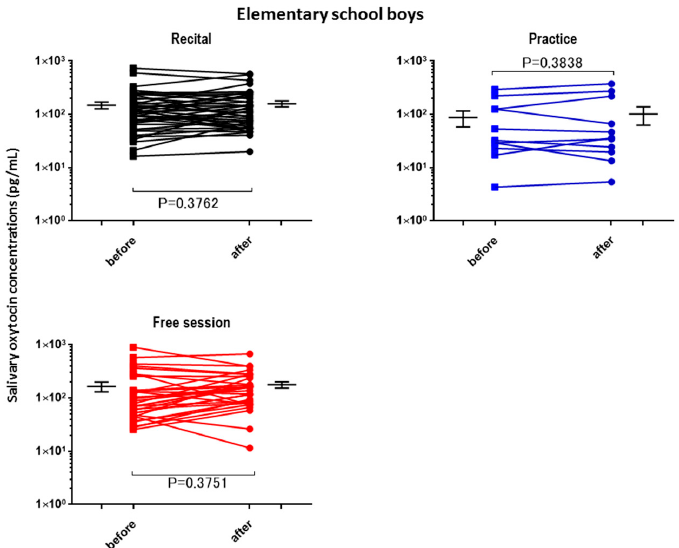
Figure 1. Changes in elementary school boys’ oxytocin levels before and after a single play session. Oxytocin levels are for the first (before) and second (after) salivary samples. Saliva was collected at each recital ( n = 52), practice ( n = 11), and free play ( n = 33) session. p values are for two-tailed Student’s t -tests.